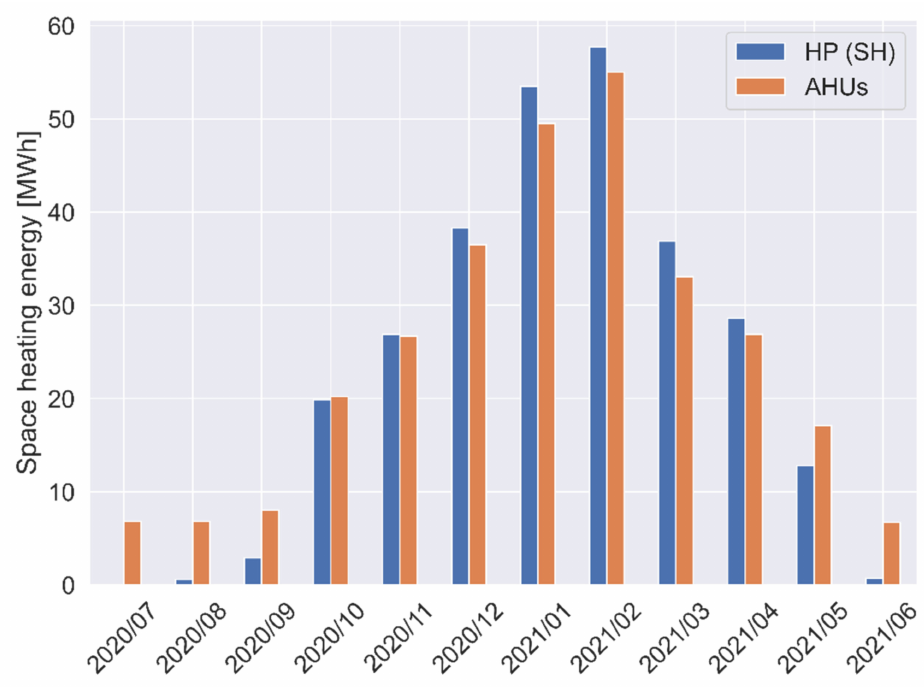
Figure 25. Space heating energy: comparison between calculations heat pump condenser and at the AHU